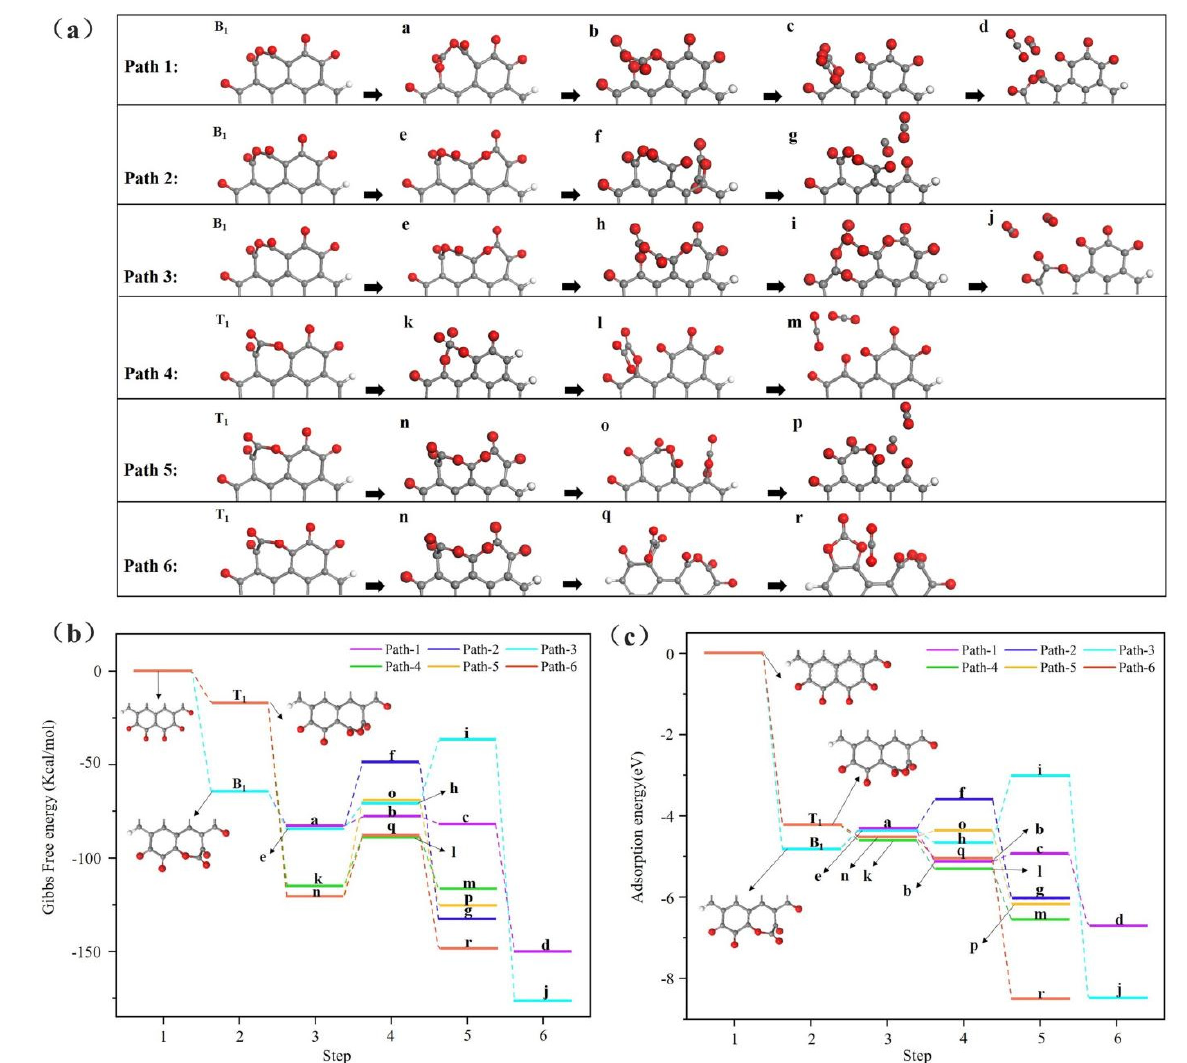
Figure 6. ( a ) Six possible paths for oxygen adsorption on anode surface; ( b ) Gibbs free energy of six possible paths; ( c ) adsorption energy of six possible paths. The letters in the steps of ( b ) and ( c ) correspond to the letters in ( a ), representing different adsorption structures.